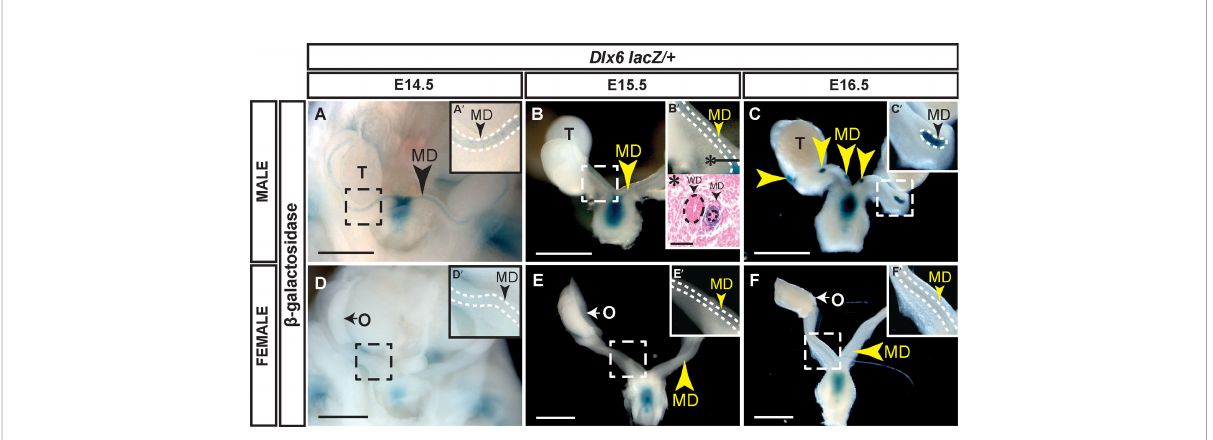
FIGURE 2 Dlx6-l acZ expression in male Müllerian duct mesenchyme but not in female Müllerian ducts. Wholemount b -gal-stained urogenital organs from E14.5 to 16.5 Dlx6-lacZ heterozygous male (A-C) and female (D-F) embryos. Arrowheads, Müllerian ducts. MD, Müllerian ducts; O, ovary; T, testis. Dashed square boxes show location of higher magni fi cation insets. Scale bars = 500 µm. (A ’ -F ’ ) Higher magni fi cation insets. Arrowheads, Müllerian ducts. MD, Müllerian duct. Dotted white lines surround MD. (B ’ *) Eosin counterstained paraf fi n section (10 µm) of wholemount b -gal- stained E15.5 Dlx6-lacZ heterozygous male. Asterisk denotes location of paraf fi n cross section. Arrowheads, Müllerian ducts. MD; Wolf fi an ducts, WD. Dotted lines surround MD and WD epithelium. Scale bars = 50 µm. Each sex and genotype analyzed n ≥